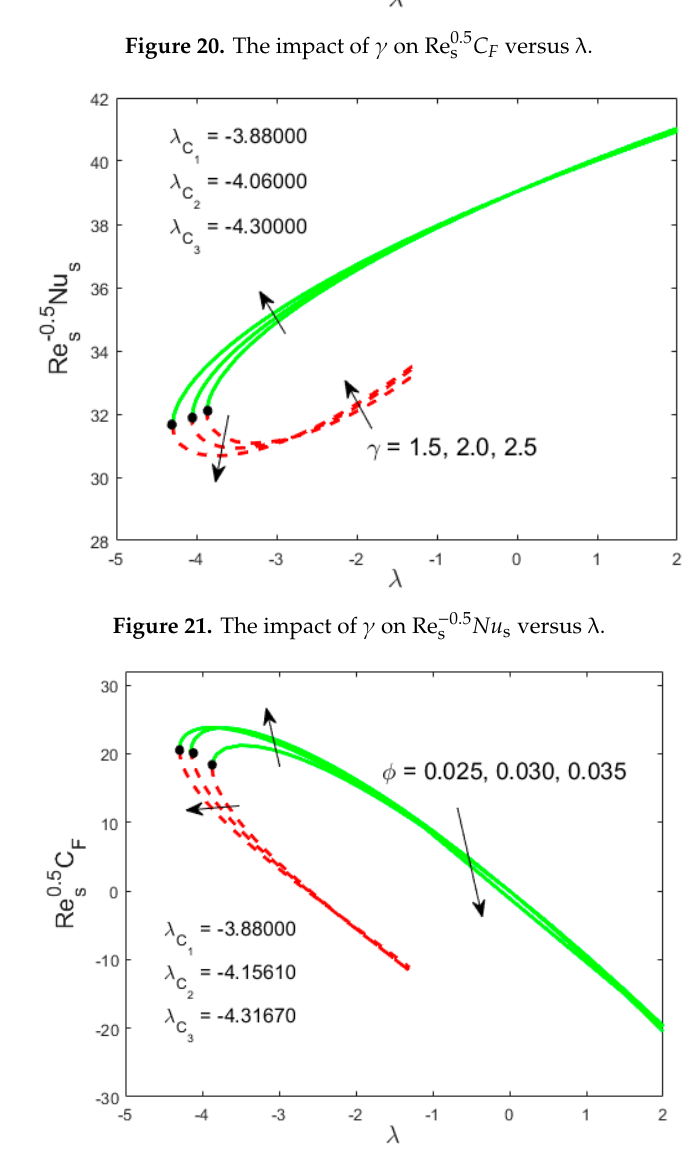
Figure 22. Influence of φ on Re 0.5 s C F versus λ